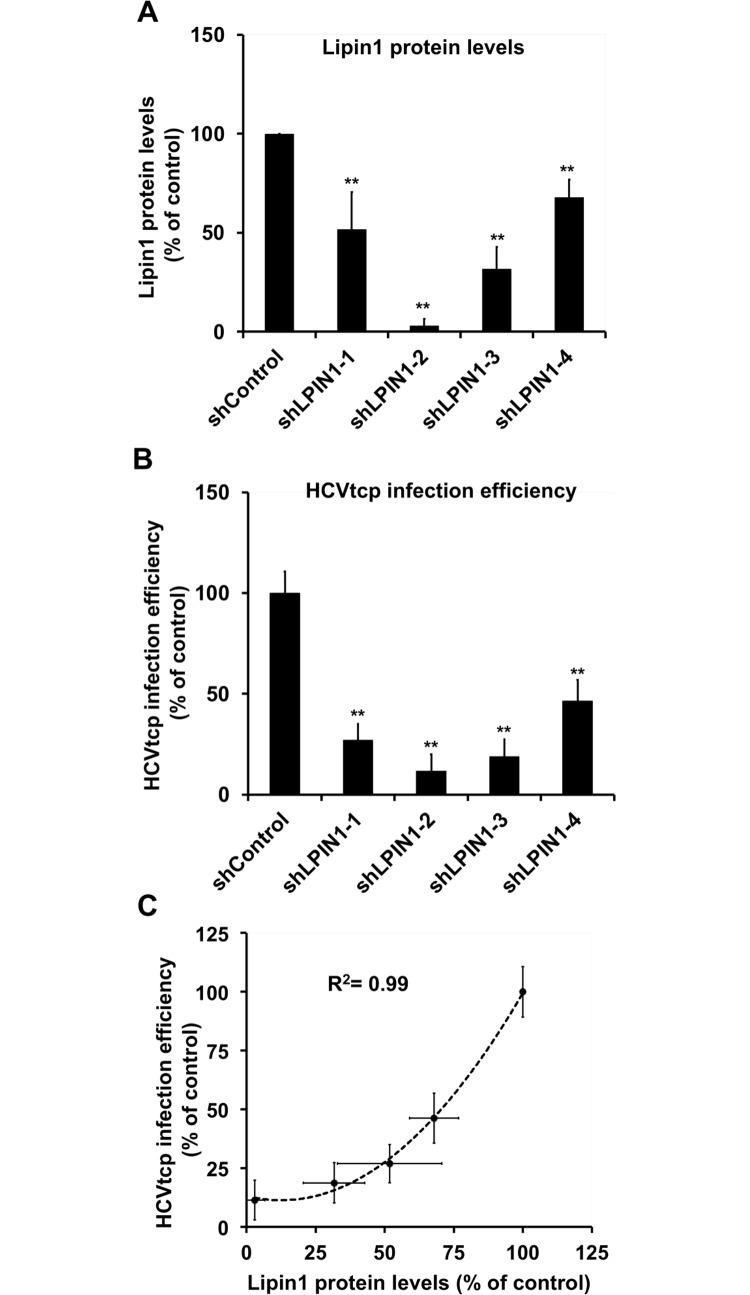
Infection of lipin1-deficient cells with HCVtcp.Huh-7 cells were transduced with lentiviral vectors expressing control or LPIN1-specific shRNAs. shLPIN1-1 and shLPIN1-2 target both isoforms, while shLPIN1-3 is specific for lipin1 isoform alpha and shLPIN-4 for isoform beta. Silencing was verified at day 7 post-transduction and control and silenced cells were inoculated with HCVtcp. Luciferase activity was determined in the different cell lines 48 hours post-inoculation. (A) Total lipin1 protein quantitation by Western-Blot. (B) Relative HCVtcp infection efficiency. (C) Plot displaying lipin1 expression data versus HCVtcp infection efficiency and the correlation index adjusted to an exponential curve. Data are shown as average and SD of four independent experiments performed in triplicate (n = 12). Statistical significance was determined using Student´s t-test (*p<0.05; **p<0.01).